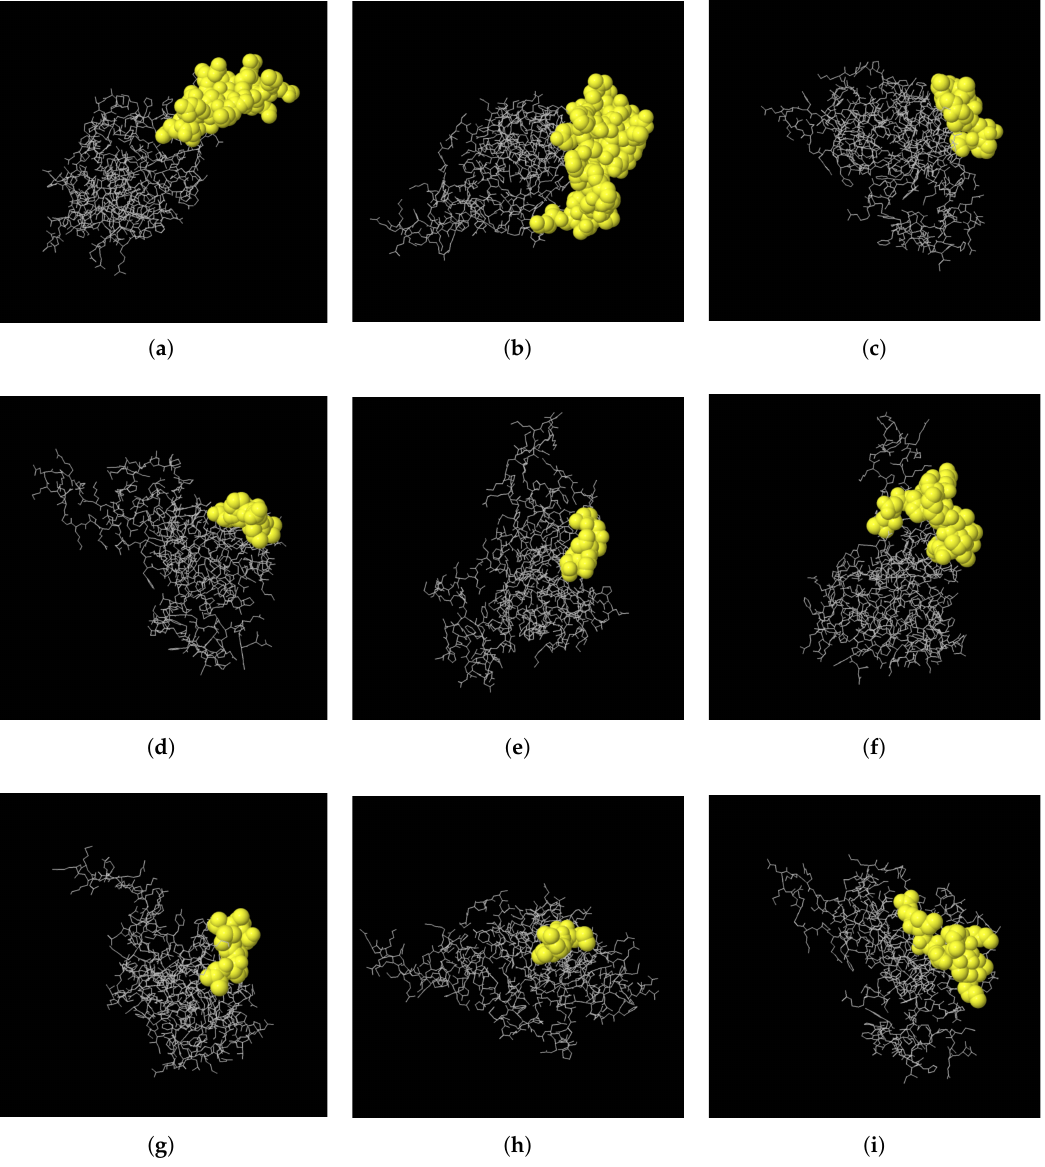
Figure 12. Three-dimensional representation of discontinuous epitopes ( a – i ) of cLin-28. The epitopes are shown in yellow, and the bulk of the cLin-28 protein is shown in grey